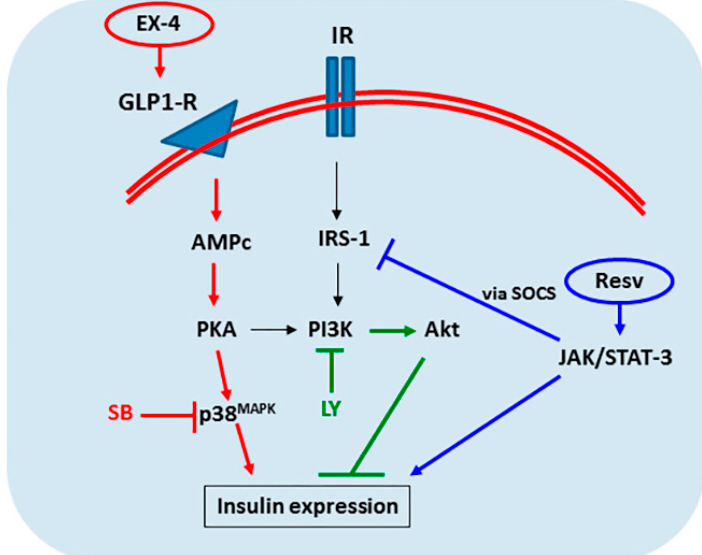
Figure 7. Schematic representation of some of the signaling pathways involved in the di ff erentiation of ADSCs into IPCs. The increase in insulin expression by ADSCs is dependent on a set of signaling pathways. The MAPK / p38 (red) and Jak / STAT-3 (blue) pathways act positively on the di ff erentiation of cells into insulin-producing cells, whereas the PI3K (green labelled) pathway acts negatively. Exendin-4 has been shown to be a good inducer of cell di ff erentiation by enhancing p38 phosphorylation, which is inhibited by SB203580 (SB). PI3K inhibition by LY294002 (LY) augmented insulin production in all protocols of di ff erentiation. Resveratrol (Resv) activates the Jak / STAT-3 pathway, culminating in insulin expression, but to a lesser extent when compared to